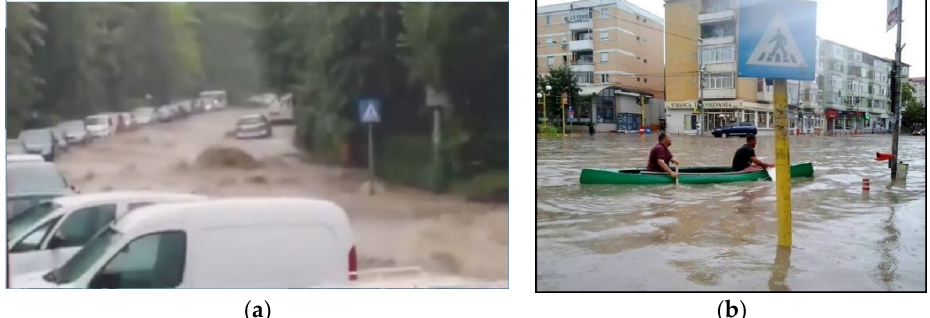
Figure 3. Flooded areas in Tulcea during the heavy rains in: ( a ) 2013—Intersection of the Isaccea street with Unirii street; ( b ) 2016—Lieutenant Gavrilov Street. Partially, the existing sewage network is a combined system and separate system, marked with yellow, are presented in Figures 5 and 6.